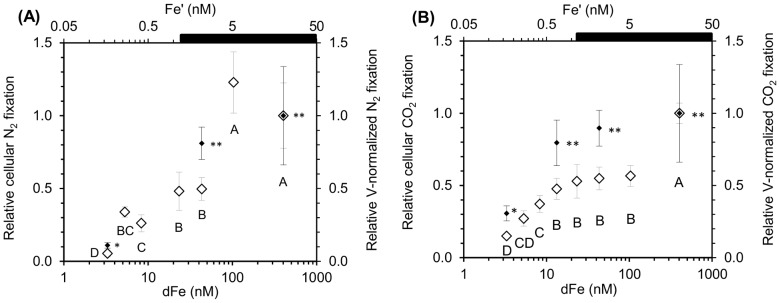
Influence of Fe availability on N2 and CO2 fixation rates of C. watsonii.(A) Relative N2 fixation rates and (B) relative CO2 fixation rates of C. watsonii related to dFe and Fe′ concentrations, in log scale. Open and filled symbols correspond to the rates per cell and V-normalized rates respectively. Error bars represent standard deviation; different letters and different numbers of star correspond to statistically different means (p<0.05) for cellular and V-normalized rates, respectively. The black bar indicates the region of expected Fe hydroxide precipitation.